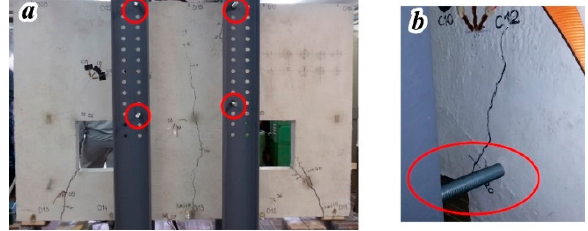
Figure 15. Out-of-plane stability of the specimen: ( a ) position of the spacers and ( b ) spacer.